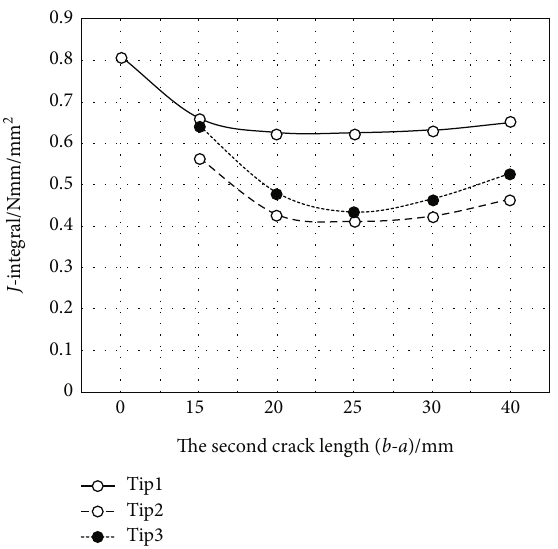
Figure 7: The J -integral variation with the distance of three noncollinear cracks.